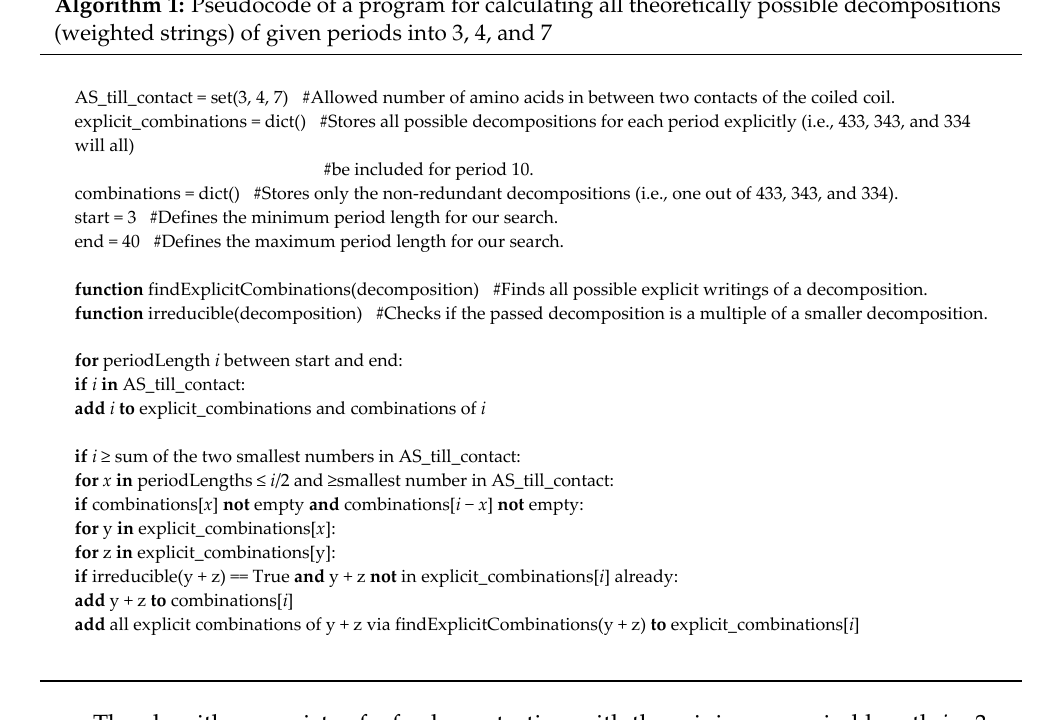
Figure 8. Input parameters for the CC+ dynamic search interface. Retrieval of any non-redundant dimeric coiled coils. SOCKET identifies knobs-into-holes packing by checking if an amino acid residue of one helix is located in a hole formed by four amino acids of the partner helix. A hole is formed if the center of mass of the side chains of the four-hole residues are located in a distance to the center of mass of the knob residue not exceeding a specified distance cutoff. Although coiled-coil interactions are often referred to in a generalization as hydrophobic interactions [35,36], in principle any amino acid can participate in knobs-into-holes inter- actions [37]. Polar amino acids can often participate in interhelical interactions by